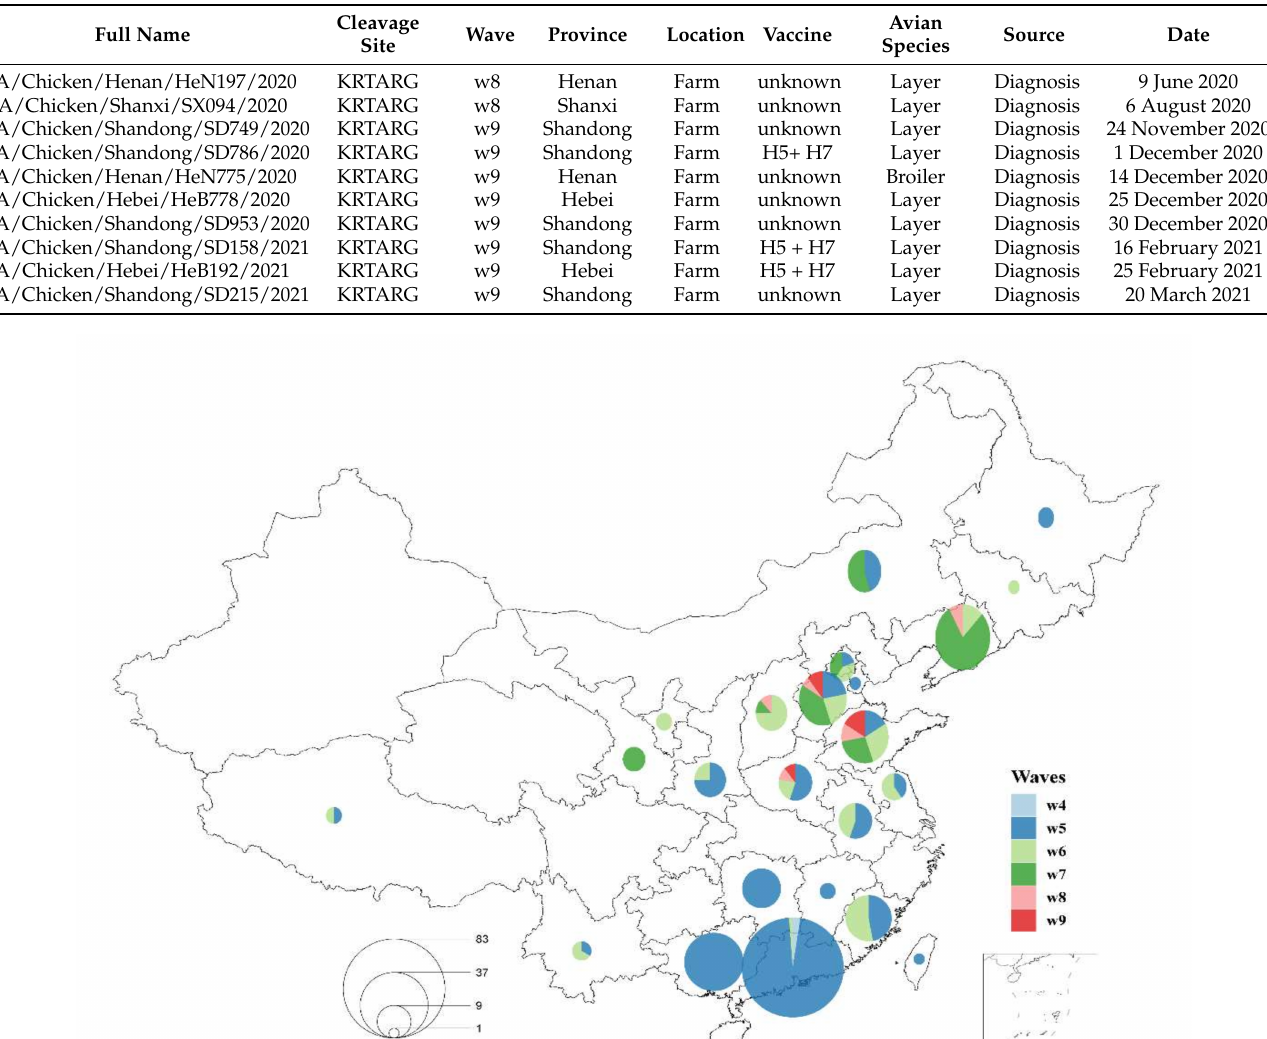
Table 1. HP H7N9 AIVs isolated from October 2019 to April 2021.